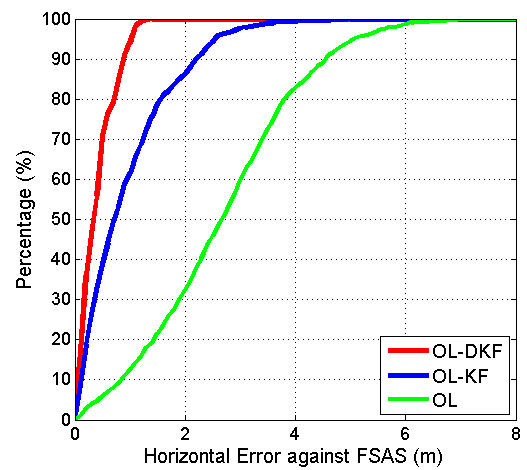
Figure 18. Position error probability of the unblocked road test.